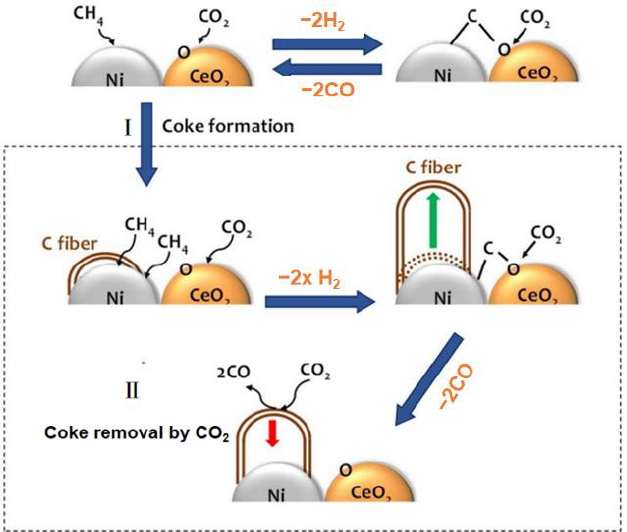
Figure 5. Carbon deposition and decarbonization on Ni/CeO 2 catalyst [56].